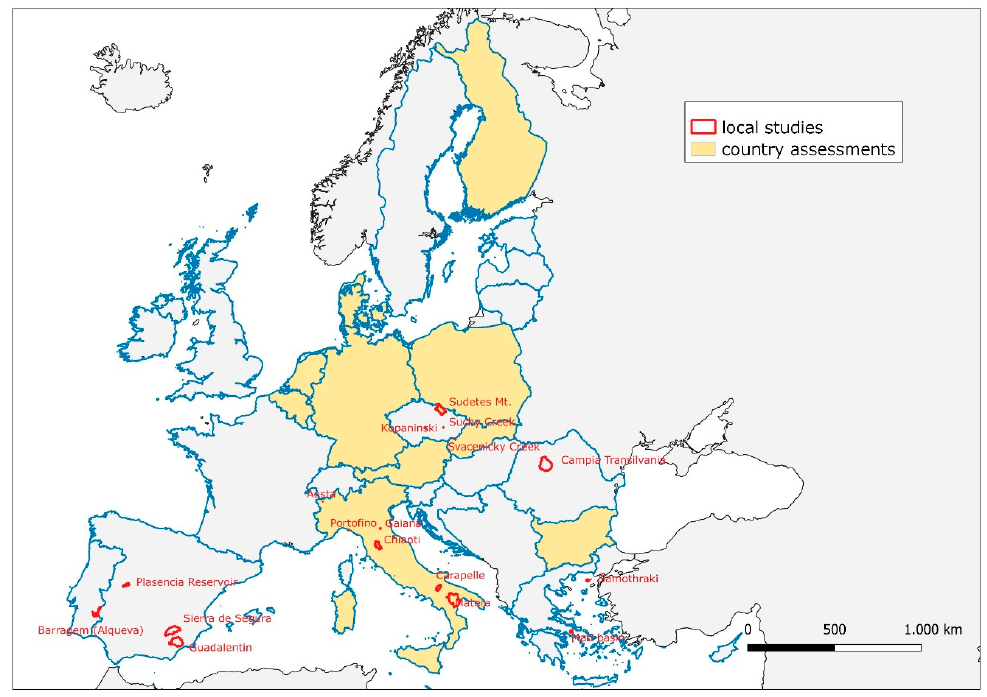
Figure A1. Country assessments (yellow background) and local studies (red line) compared with RUSLE2015 results.